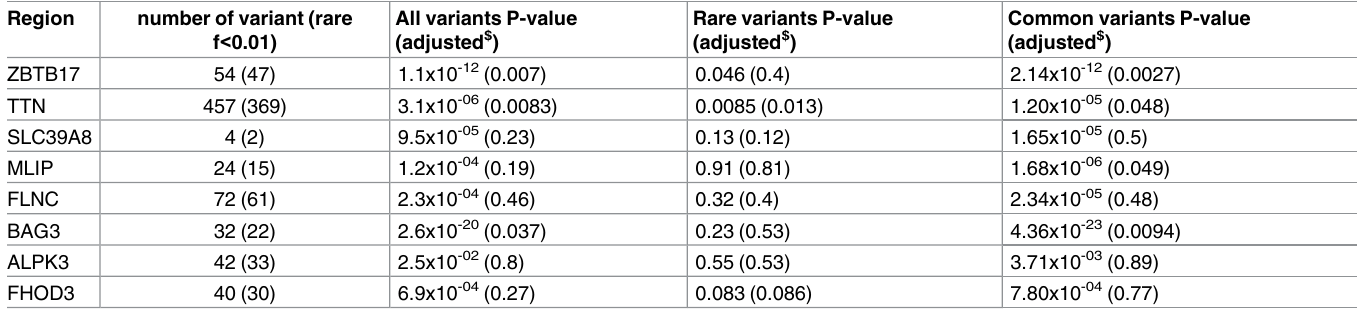
P-values adjusted on